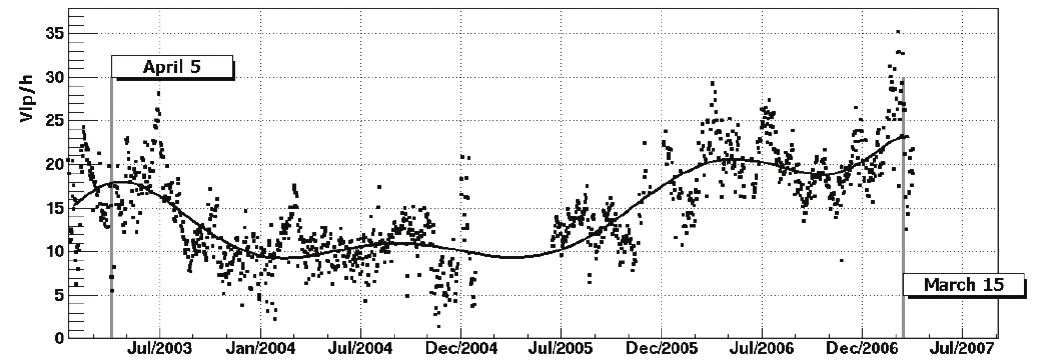
Fig. 18. VLP hourly occurrence rate since January 17,